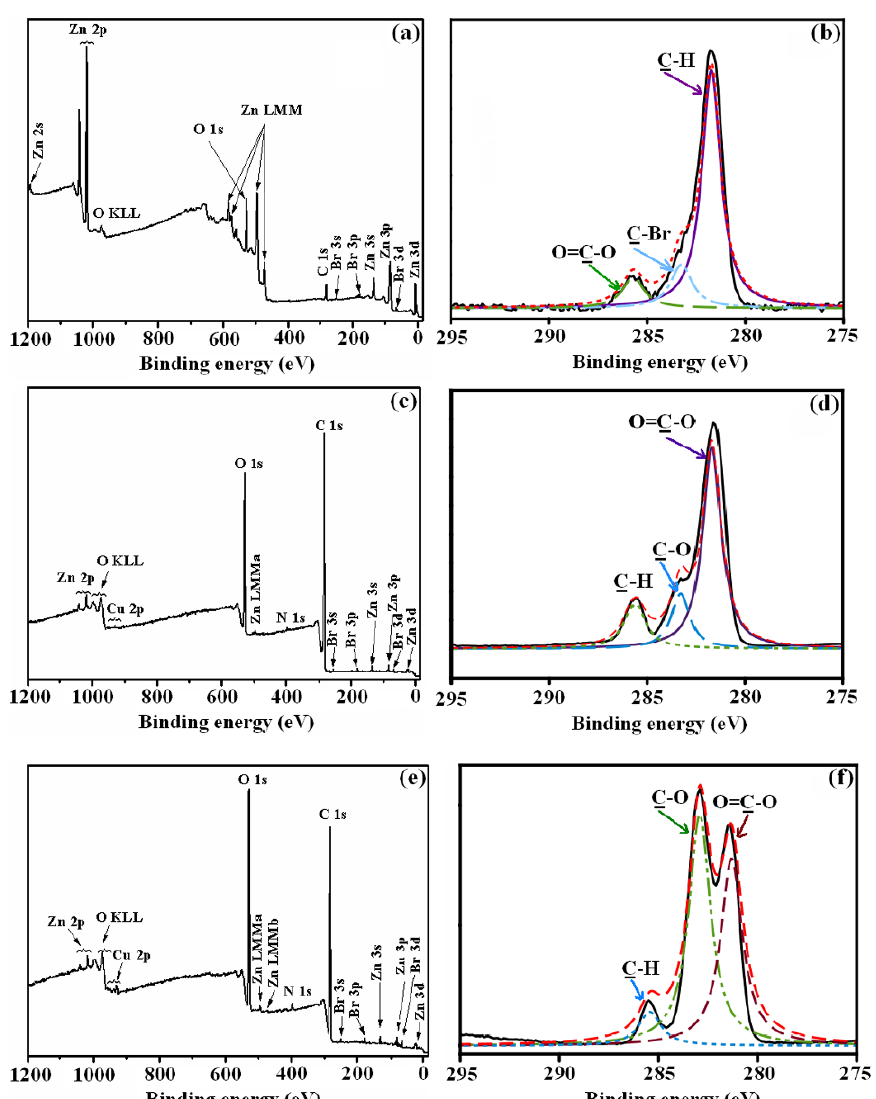
Figure 4. The XPS wide scan and C1s core-level spectra of ZnO-BEI (a,b), ZnO-PCEMA-Br (c,d) and ZnO-PCEMA- b -PEGMA-Br